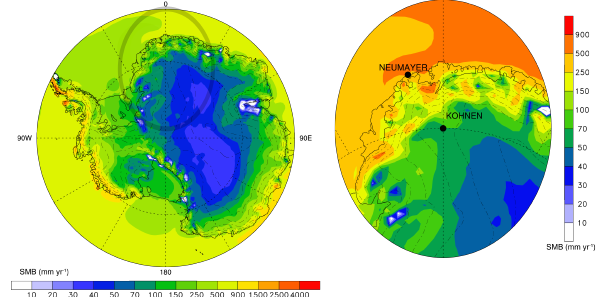
Fig. 1. The SMB distribution (from RACMO2/ANT for the period 1958–2002, Van de Berg et al., 2005) on the whole Antarctic conti- nent (left) and zoomed in on the region between 20 ◦ E and 20 ◦ W, as indicated with the circle in the left plot. Note the different scale on both plots. The locations of Neumayer and Kohnen stations are indicated on the right plot. The distance between both stations is about 550km. The topography is shown in both plots by the dashed height contours (500m